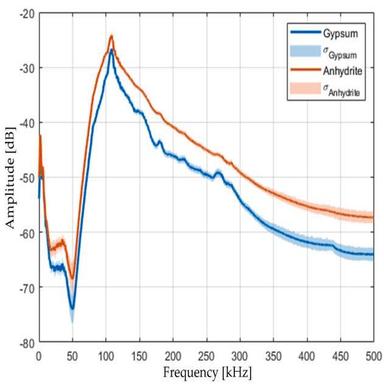
Frequency spectra of gypsum and anhydrite after applying the Fourier transformation.